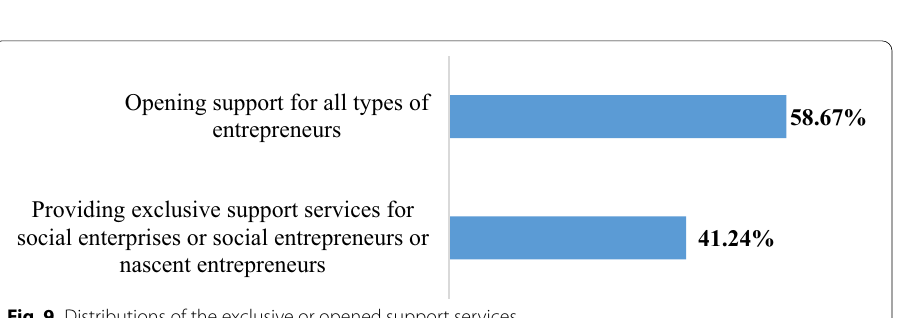
Fig. 9 Distributions of the exclusive or opened support